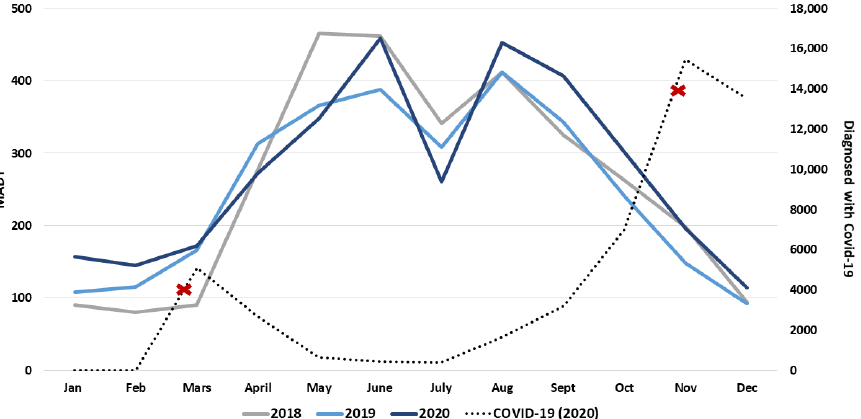
Figure 2. Monthly national bike traffic from January 2018 to December 2020 highlighting the monthly number of individuals diagnosed with COVID-19 (2020). Red crosses illustrate implementation of national strategies to combat COVID-19. MADT stands for monthly average daily traffic.